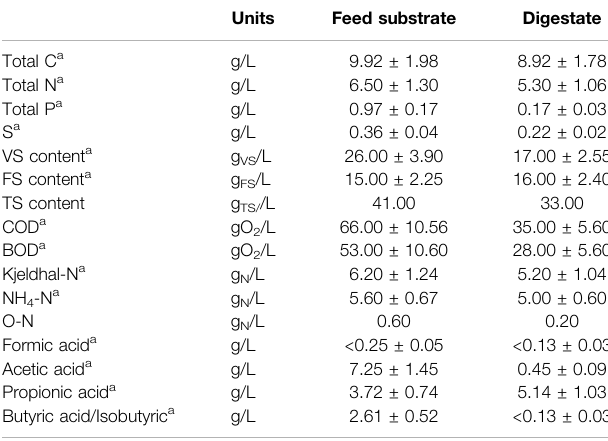
TABLE 4 | Characterization of substrate mixture and digestate